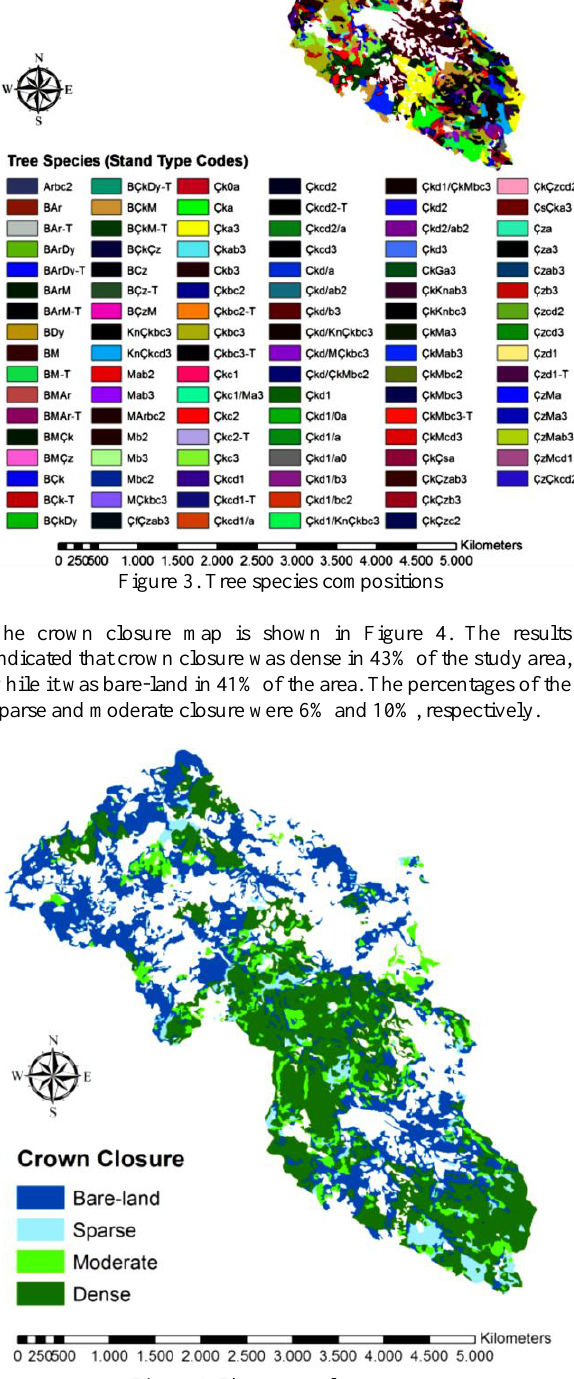
Figure 4. The crown closure map